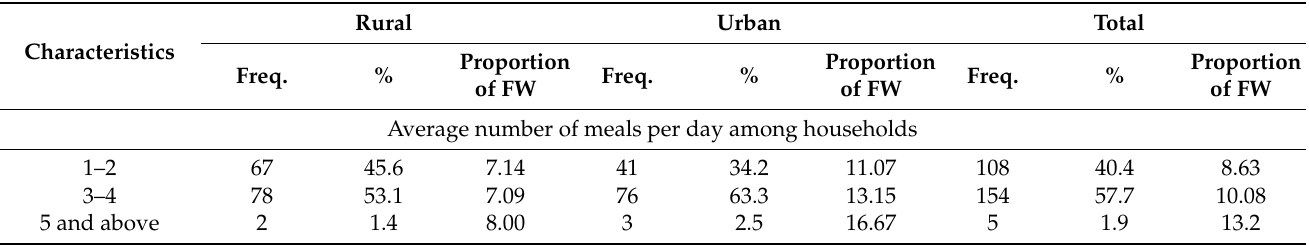
Table 2. Critical factors in food waste